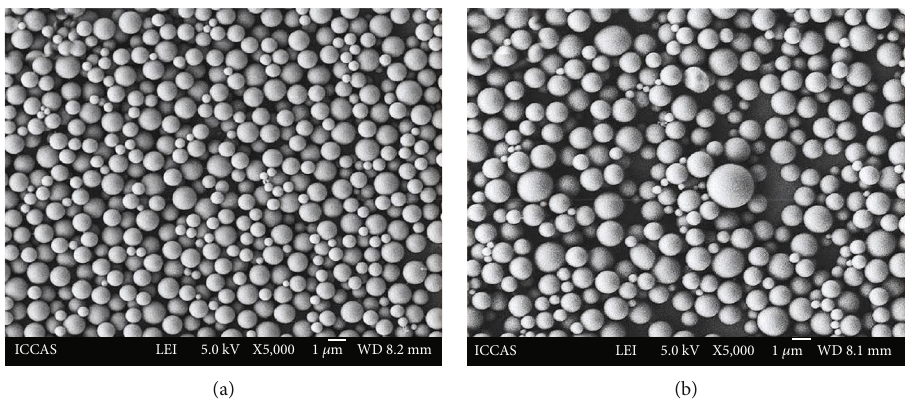
Figure 5: SEM micrographs of starch microcapsules prepared with (a) DCM and (b) EA [27].